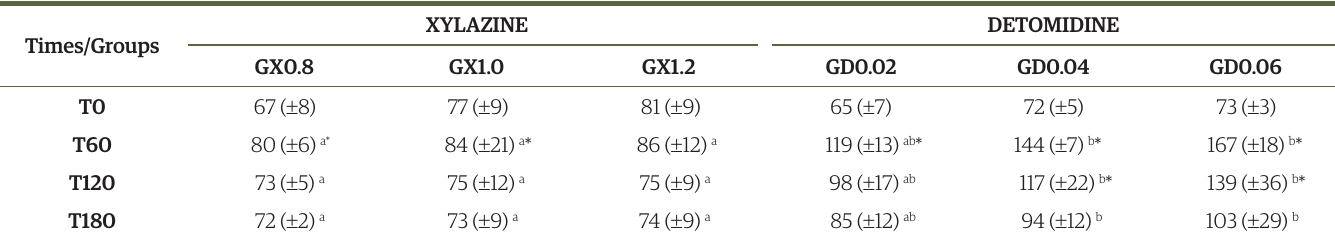
a, b, ab = different letters indicate a significant difference between groups for each moment (p<0.05). * = significant difference for the moment compared to T0 (p<0.05).